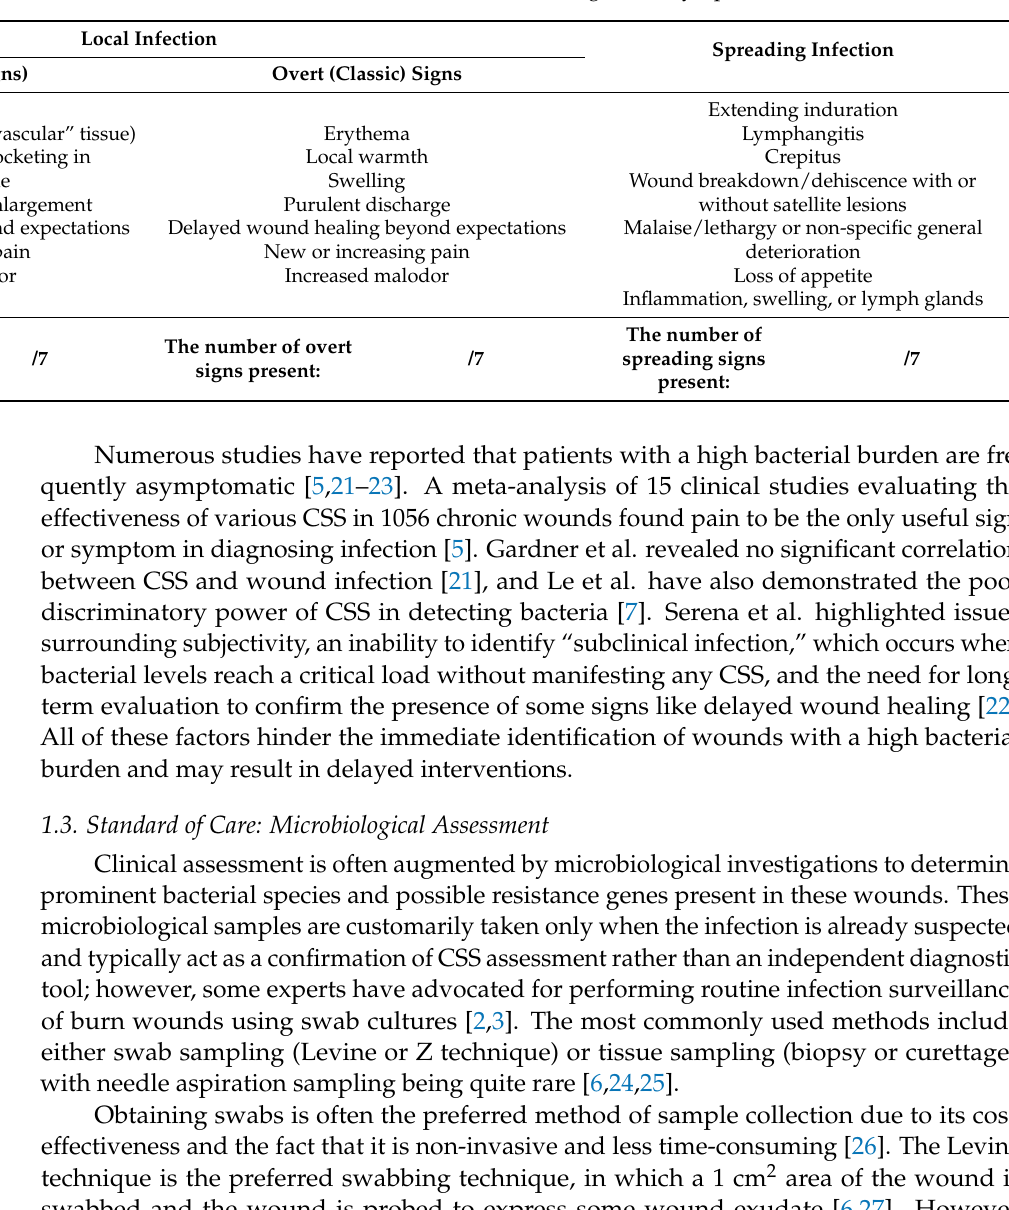
Table 1. International Wound Infection Institute (IWII) checklist of clinical signs and symptoms of infection. Local Infection Covert (Subtle Signs) Overt (Classic)